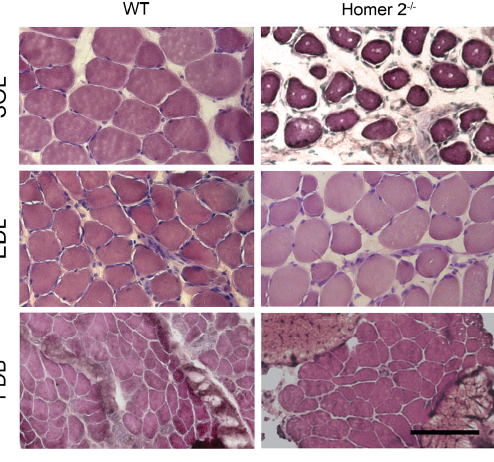
Figure 1. Light microscopy of SOL, EDL, and FDB cryosections from WT and Homer 2 -/- mice. Representative haematoxylin and eosin staining of transverse sections of SOL (upper panels), EDL (middle panels), and FDB (lower panels) from WT and Homer 2 -/- mice. In EDL of Homer 2 -/- mice, some angular fibres were observed. Scale bar = 100 µ m. Table 1. SOL, EDL, and FDB morphometry in WT and Homer 2 -/- mice.